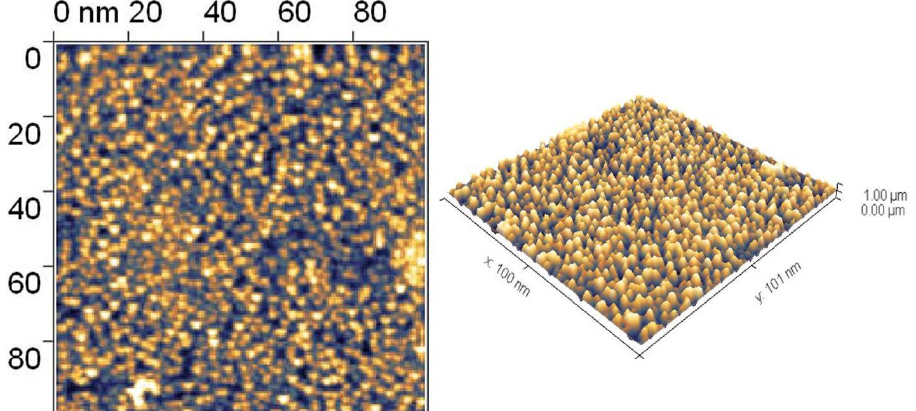
Figure 4. 2D and 3D AFM-image of film surface.